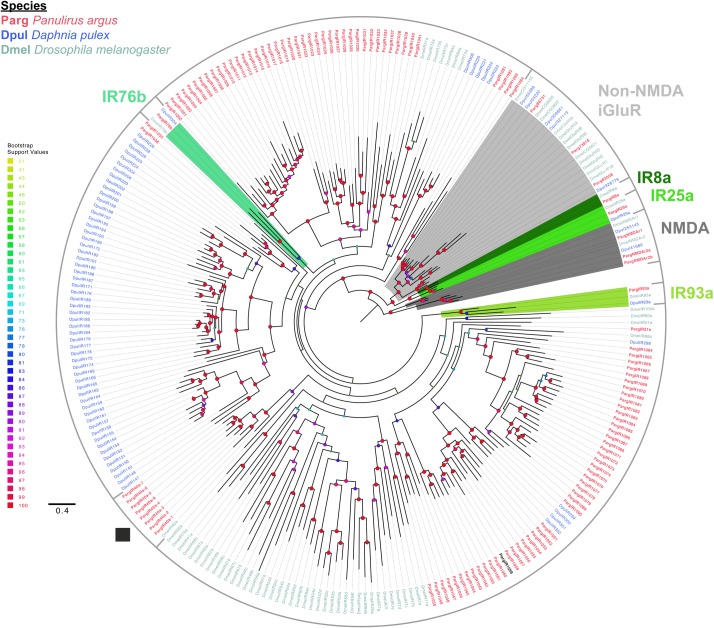
Maximum likelihood phylogenetic tree of iGluRs and IRs.Colored areas of the tree represent iGluRs (shades of grey) and co-receptor IRs (shades of green). ■ indicates conserved IR sequences of the IR40a family. Sequence colored in black indicates the Parg divergent IR that has an amino acid substitution in the conserved glutamate binding site in the S1 region of the LBD. The tree was built under LG+F+G4 model of substitution with 1000 ultrafast bootstrap (UFBoot) replications and visualized on FigTree v1.4.2. Bootstrap values on some internal branches of divergent IRs are low due to incomplete sequences and high sequence divergence across the different species. The tree was unrooted but drawn with the NMDA clade as root. The scale bar represents expected number of substitutions per site.